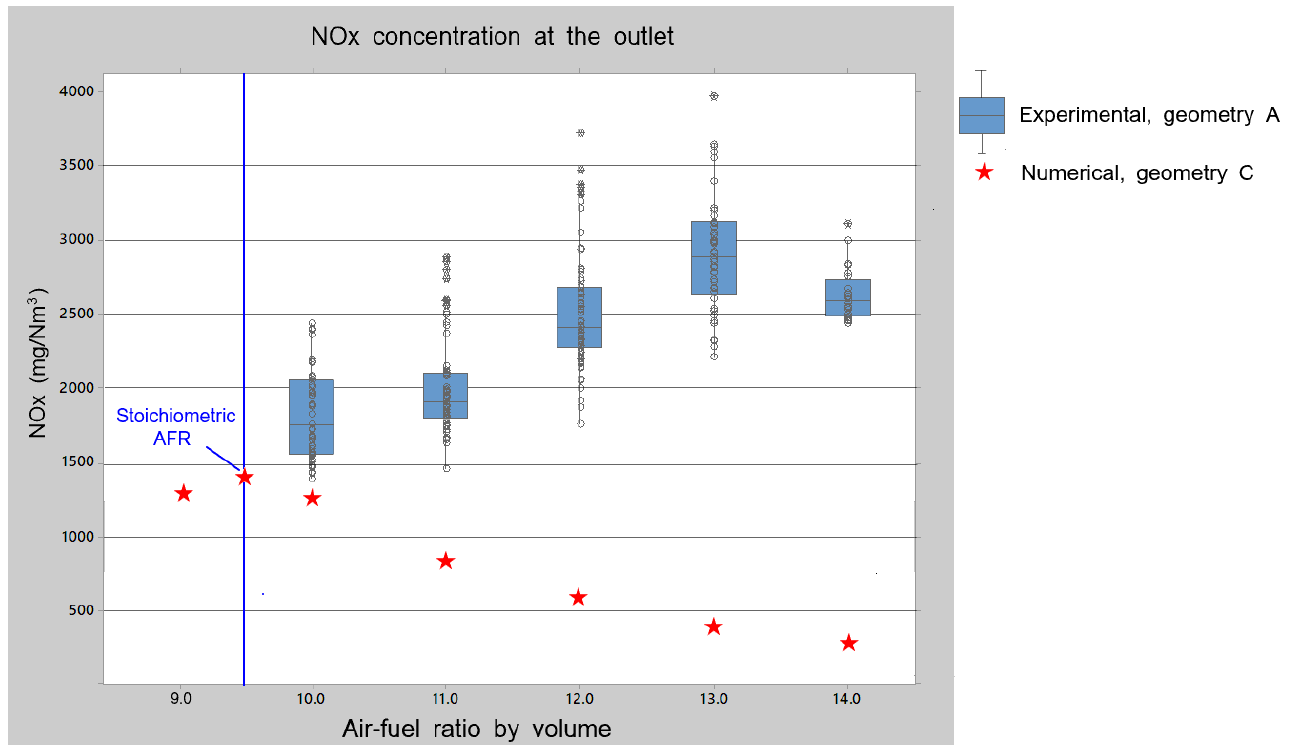
Figure 15. Average thermal NOx concentration at the outlet of the kiln for different